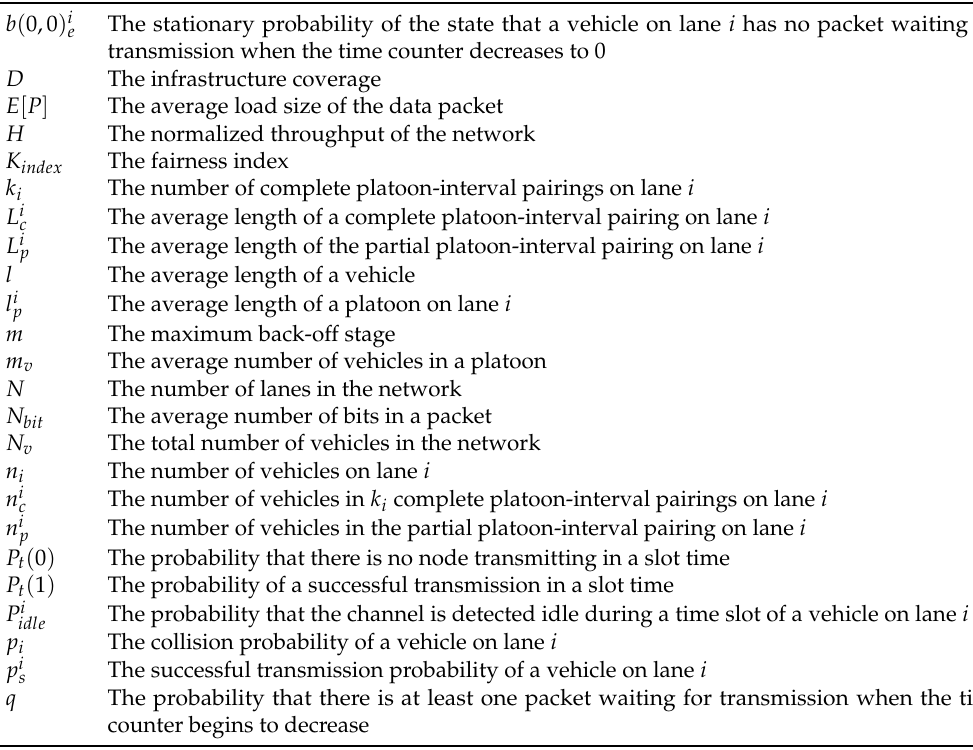
Table 1. Parameters used in the analytical